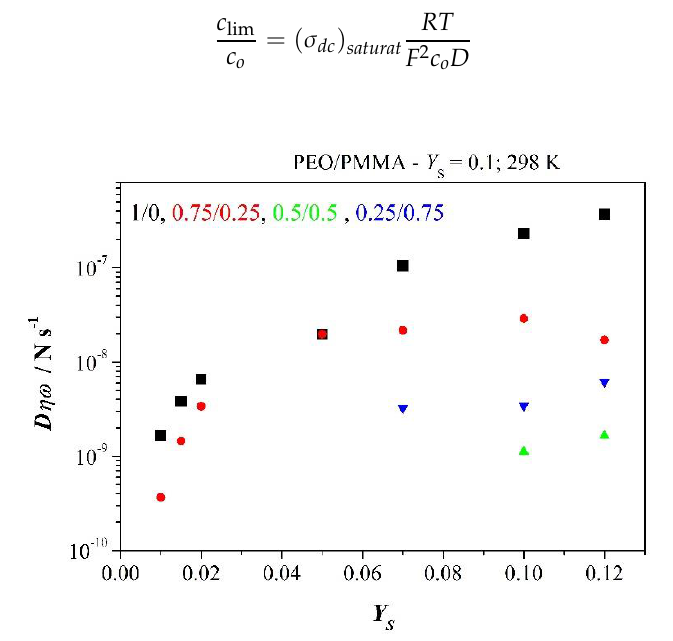
Figure 12. Force rate D ηω versus concentration of added salt Y S. Table 1. About dynamics in PEO/PMMA blends with Y S = 0.1 Li-salt at 298 K. Generalized diffusion coefficient, limiting solubility c lim /c o , drift velocity and entropy production.